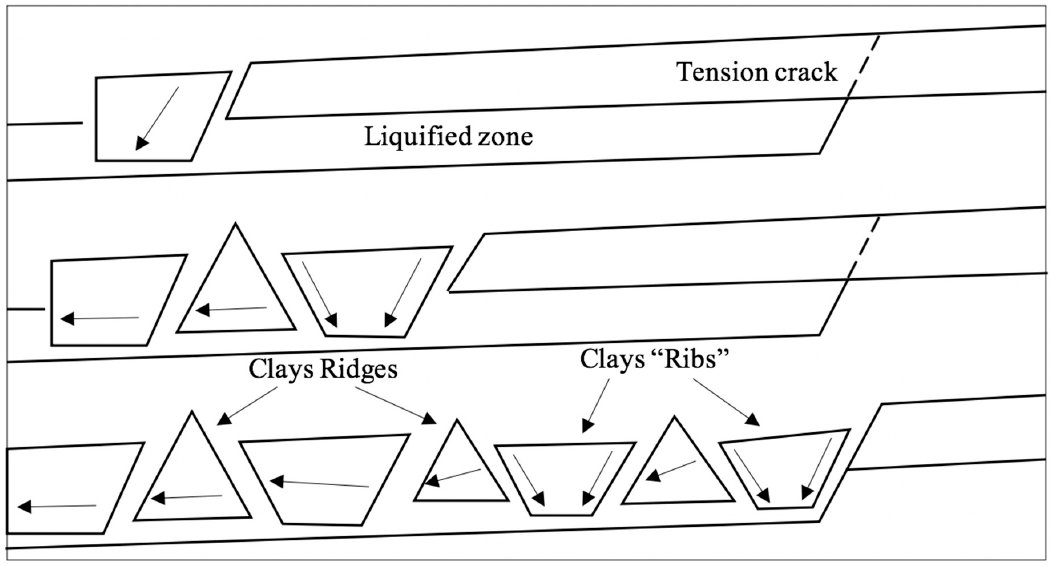
Figure 3. Progression of a "retrogressive" landslide in sensitive clays via the dismembering of an undisturbed soil monolith evolving on a layer of liquefied soil [12].